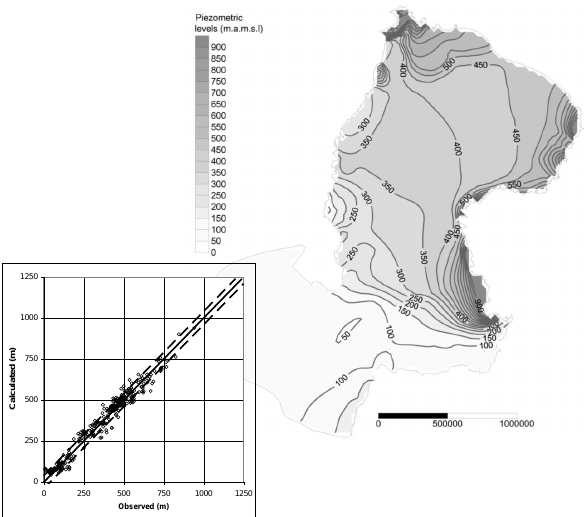
Fig. 7. Simulated and observed piezometric levels (ma.m.s.l.) for zonation Z5 (linear regression and contour